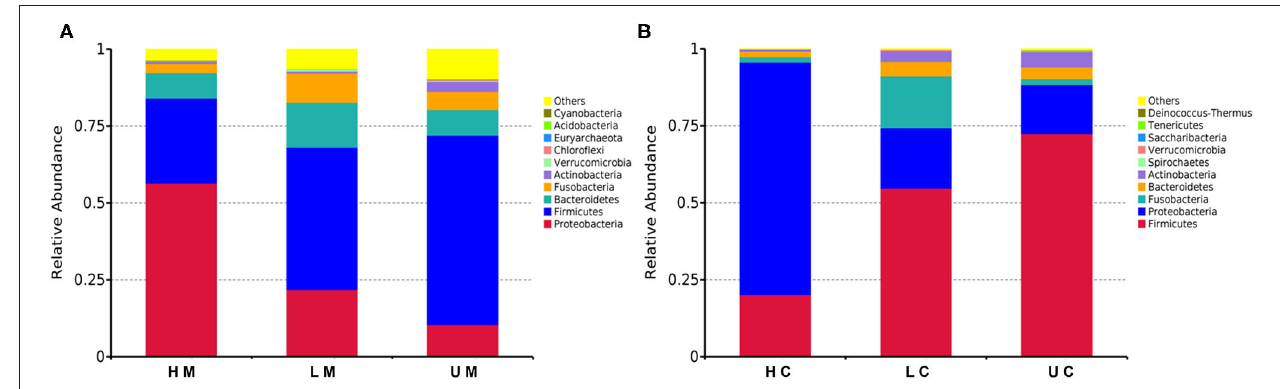
FIGURE 2 | Histogram of the dominant phyla in jejunal mucosa (A) and jejunal content (B) microbiome samples from the uninfected, low viral load, and high viral load groups.